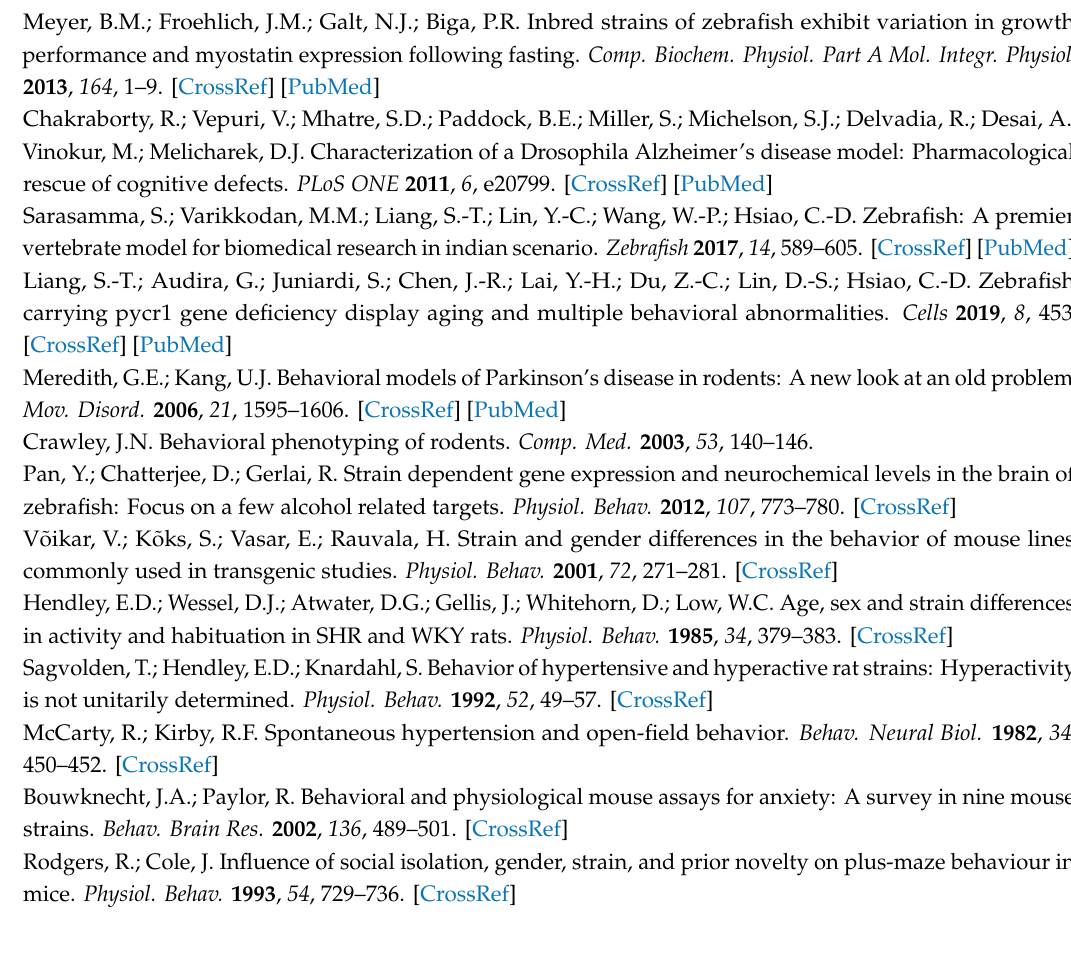
Figure S1. Locomotor activity endpoint comparisons between the AB zebrafish (white), absolute zebrafish (red), TL zebrafish (blue), golden zebrafish (green), PET zebrafish (purple), and the WIK zebrafish (orange) in the predator avoidance test. Figure S2. Comparison of the average coe ffi cient of variation of the six di ff erent zebrafish strains (AB (black), absolute (red), TL (blue), golden (green), PET (purple), WIK (orange)) in the six zebrafish behavior tests with three di ff erent n numbers. Table S1. Summary of the fish behavioral endpoints measured in each behavioral test during this experiment. Table S2. The mean, median, and standard deviation (SD) of the behavior endpoints of each fish group in every time interval from the novel tank test result. Table S3. The mean, median, and standard deviation (SD) of the Puntigrus tetrazona behavior endpoints in each behavioral test. Table S4. Summary of each fish strain coe ffi cient of variation (CV) and standard deviation (SD) in each behavior